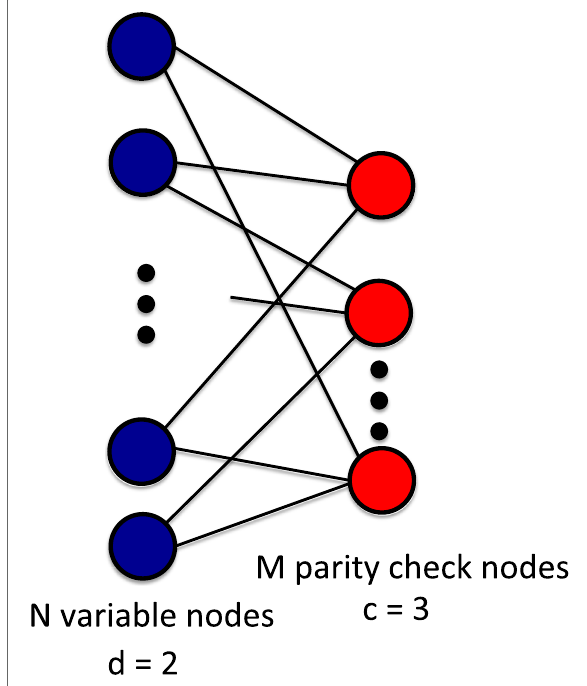
Fig. 4 Illustration of an expander graph with d = 2 and c = 3. Following coding theory terminology, we call the left variables nodes (there are N such variables), which correspond to the entries of x t , and the right variables parity check nodes (there are M such nodes), which correspond to entries of y t . In a bipartite graph, connections between the variable nodes are not allowed. The adjacency matrix of the bipartite graph corresponds to our A or A t